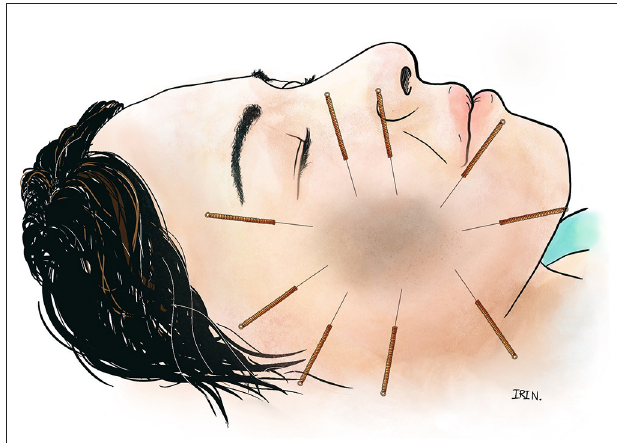
FIGURE 1 | Encircle acupuncture of a facial melasma lesion.